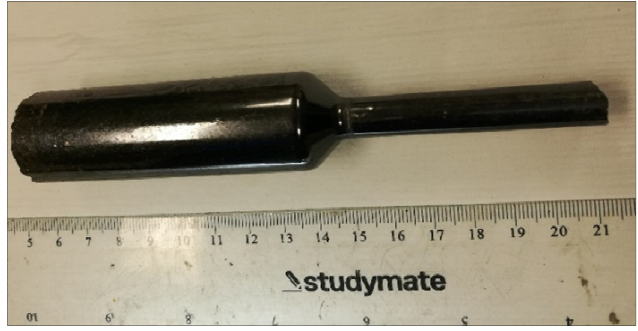
Figure 2. As-grown boule of Mn-modified PIN-PMN-PT single crystal. Shimanuki et al. grew the first relaxor-PT single crystal using the vertical Bridgman method. In their experiment, the charge was suspended inside the furnace, and it was then moved down to the lower zone to be crystallized [7]. Luo et al. used the modified Bridg- man method to grow PMN-PT single crystals [6]. Instead of the suspension technique, an crucible was shaped to a tapered end enabling a single grain growth, and the crucible was also sealed with a lid that protected the contents from volatiles at high temperature. The the single crystal are: piezoelectric charge coefficient, d 33 > 2000 pC/N, dielectric constant, ε ~5500, and electromechanical coupling factor, k 33 ~93% at the MPB [6,48]. Using the mod-